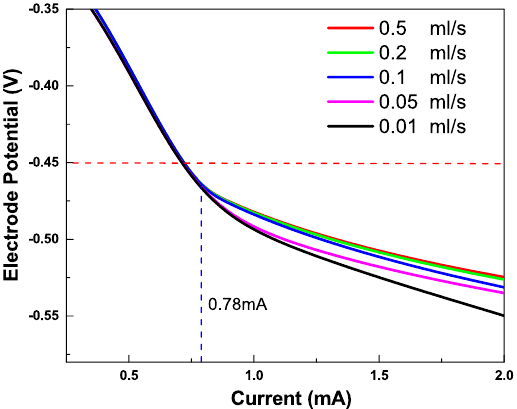
Figure 6. Simulated cathode electrode potential as a function of the current for an all-V continuous-flow PESC under different flow rates of V 3 + (0.01 M). The estimated Fermi level (electrochemical potential) is indicated in the figure as a dashed